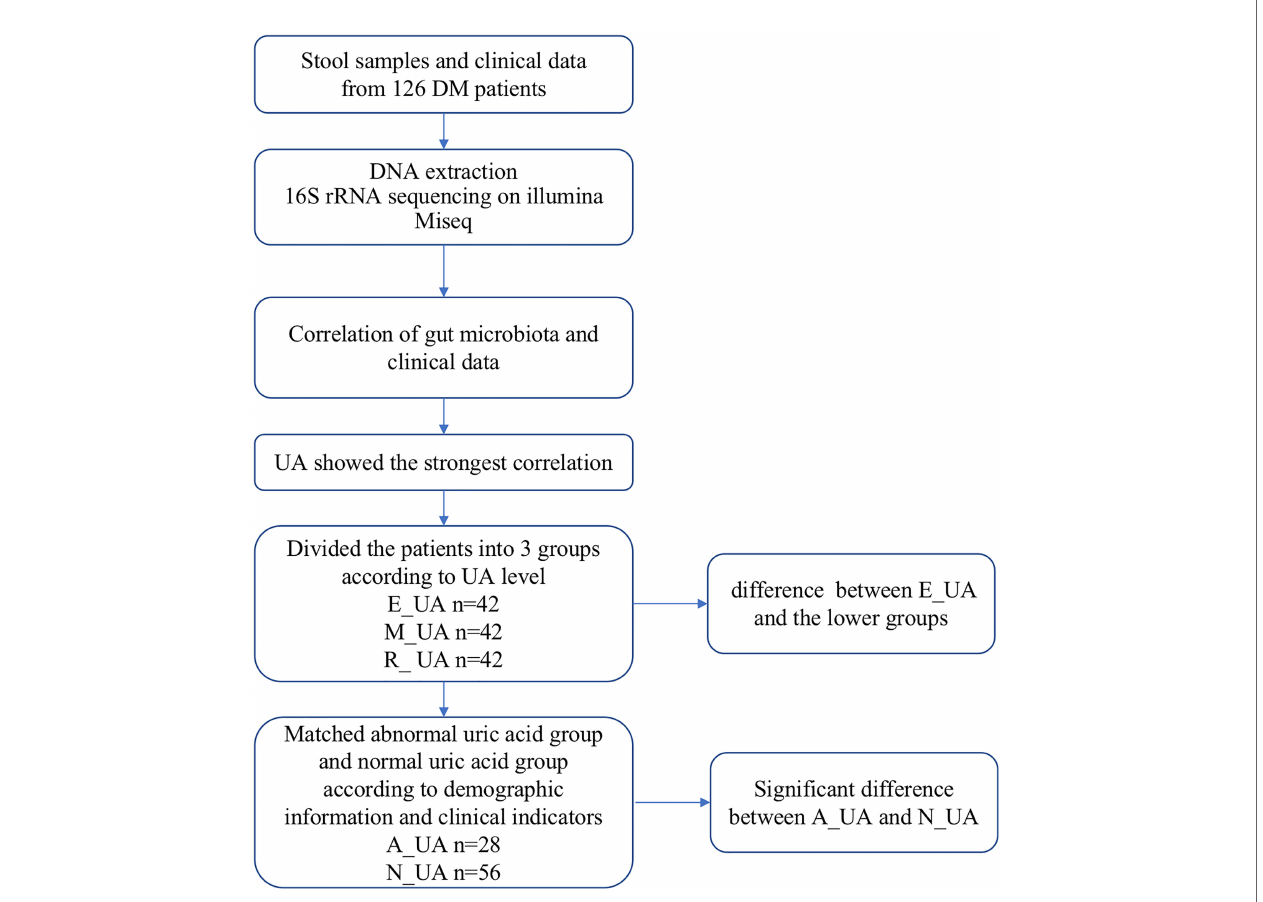
FIGURE 1 | Study design and fl ow diagram. DM, diabetes mellitus; UA, uric acid; E_UA, elevated uric acid; M_UA, moderate uric acid; R_UA, reduced uric acid; A_UA, abnormal uric acid; N_UA, normal uric acid. Matching indicators include uric acid, systolic blood pressure, diastolic blood pressure, neutrophils, lymphocytes, glucose, serum creatinine, serum albumin, total cholesterol, triglycerides, high-density lipoprotein, and low-density